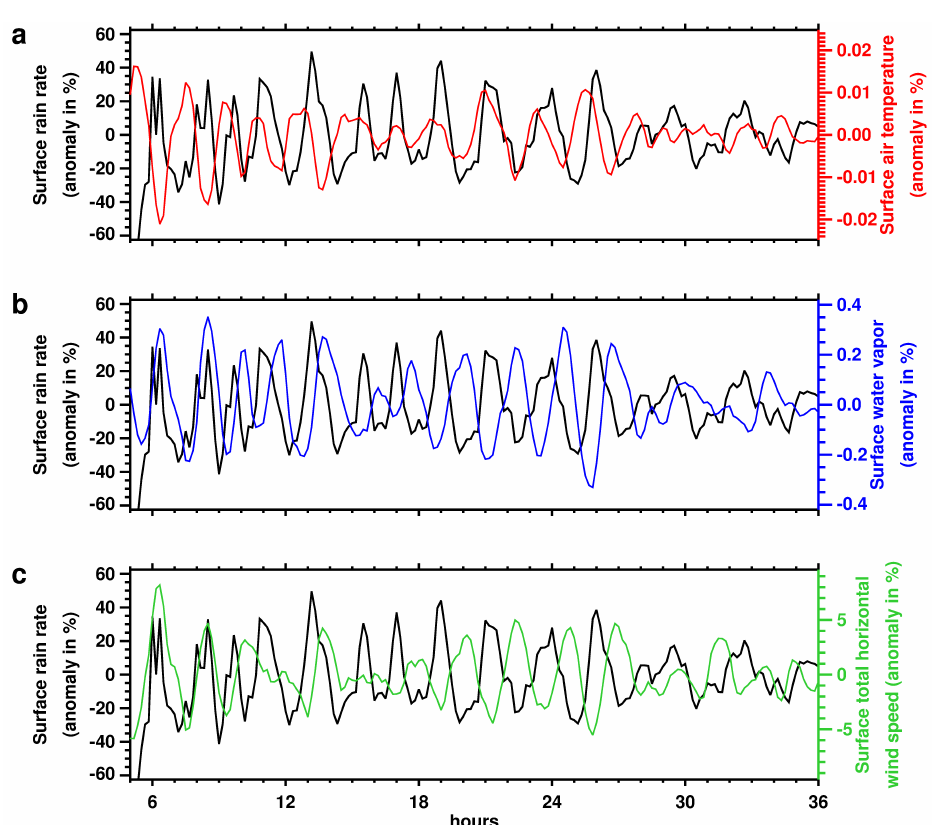
Fig. 7. Temporal anomalies (against a 3h running mean) of surface rain and (a) surface air temperature, (b) water vapor, and (c) total horizontal wind speed in simulation S ◦